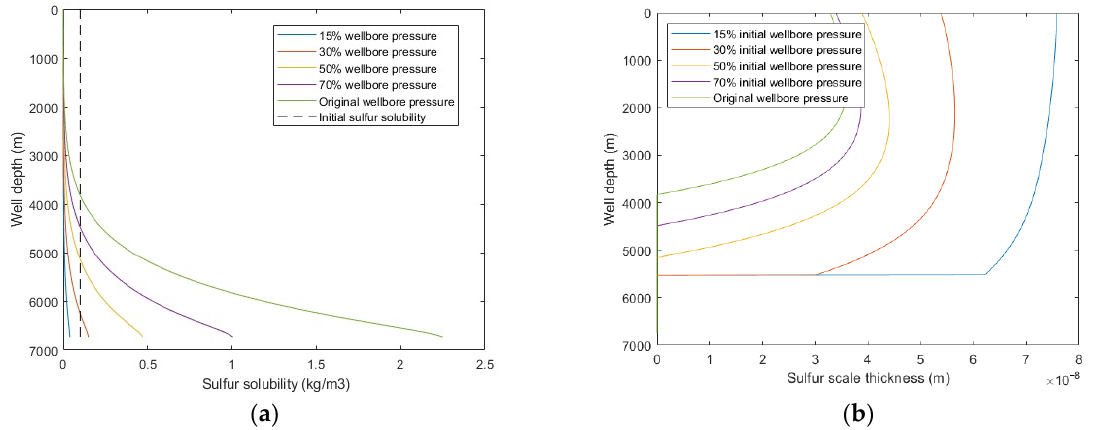
Figure 11. Calculated results with: ( a ) sulfur solubility distribution at different wellbore pressure; ( b ) sulfur scale thickness distribution at different wellbore pressure.